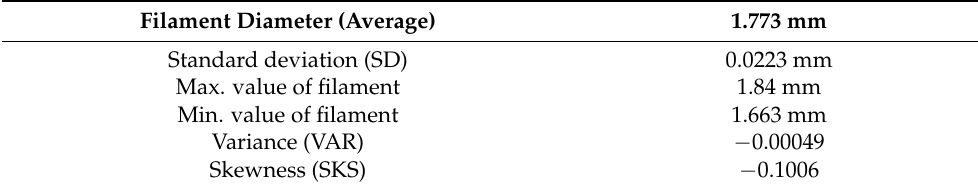
Table 2. Analysis of filament produced using descriptive statistics.